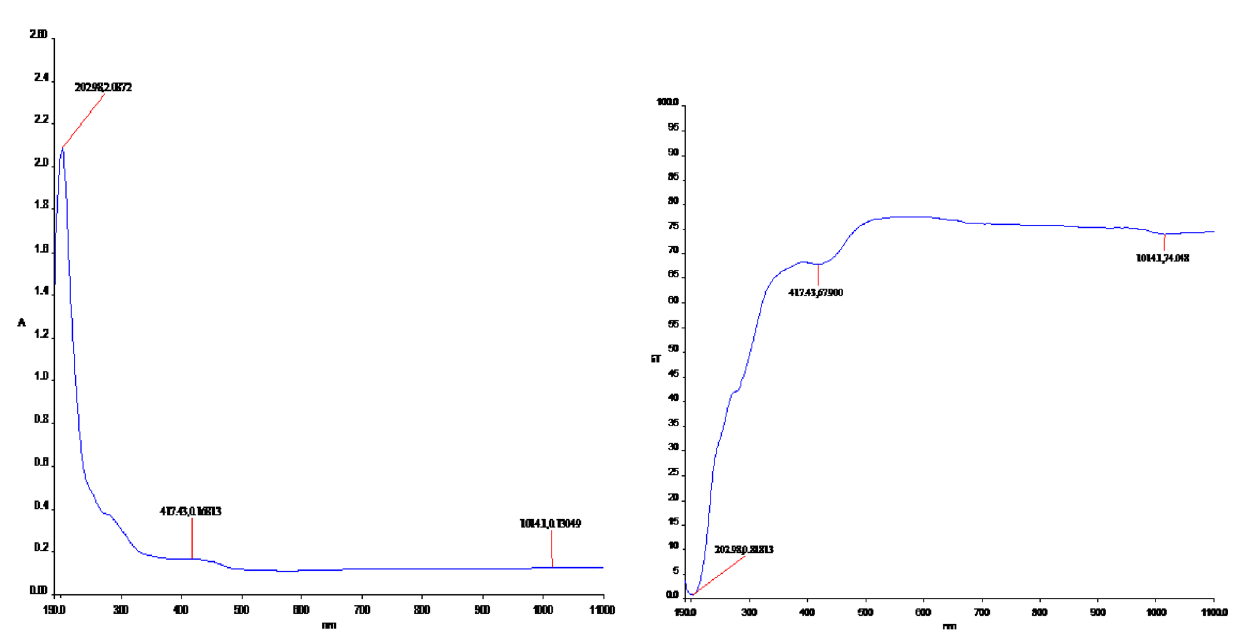
Fig. 10 Experimental absorbance and transmittance UV–Vis spectra of